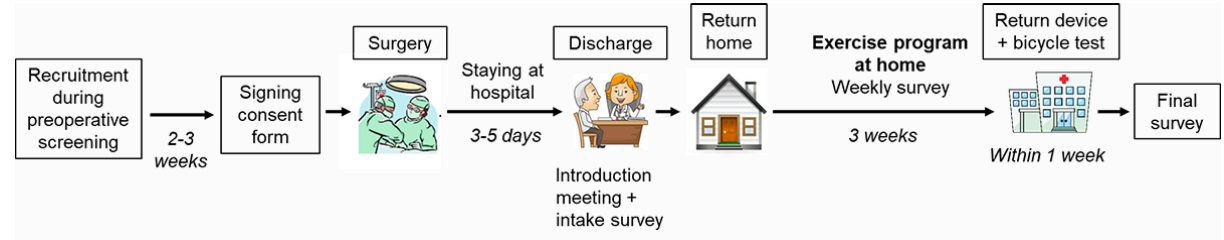
Figure 6. Patient timeline in this randomized controlled